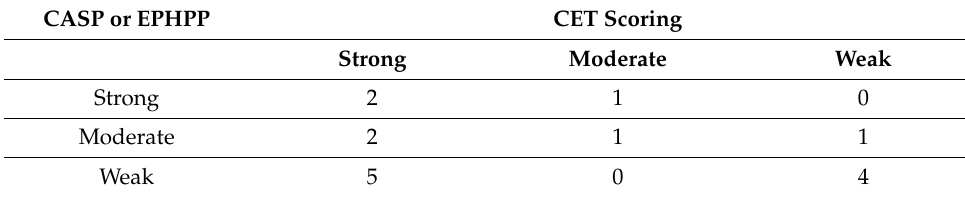
Table 2. Frequency of